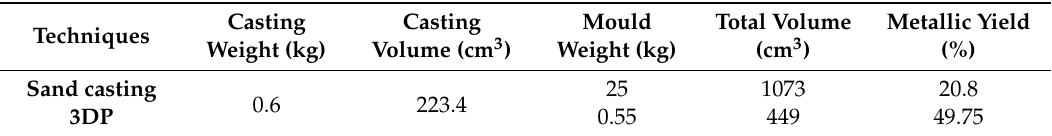
Table 3. Principal parameters of the casting parts and